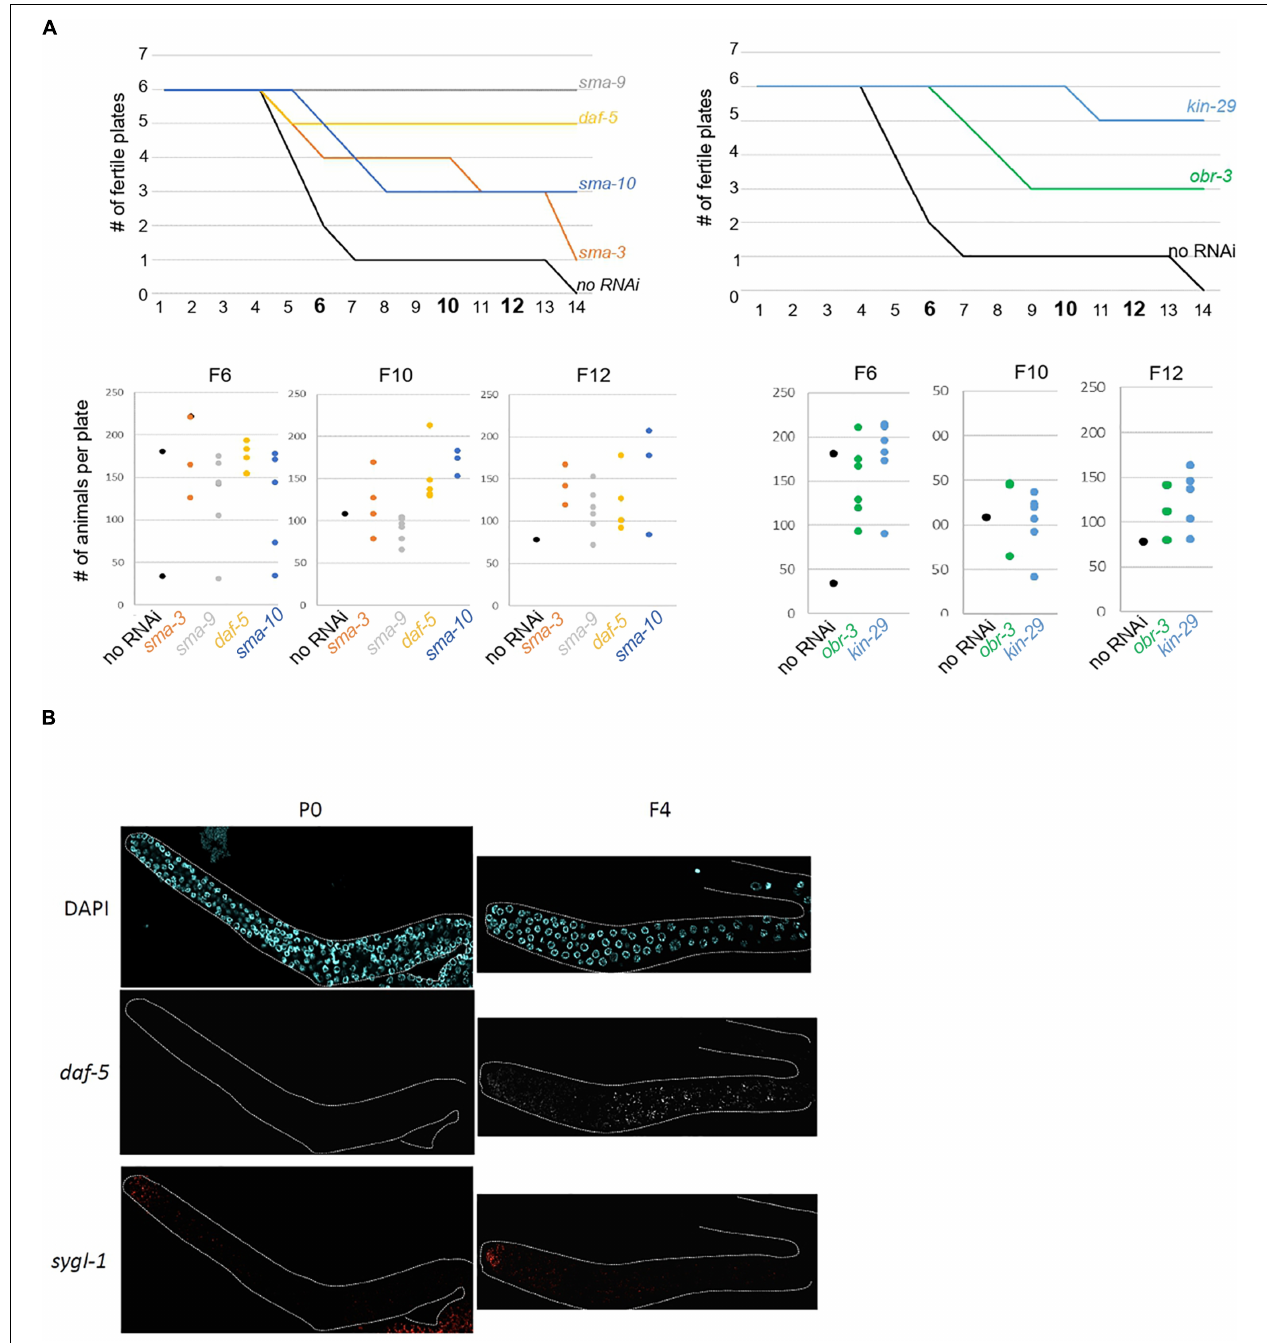
FIGURE 5 | Ectopic TGF-beta signaling contributes to loss of germline identity in set-2 mutant animals. (A) sma-9 , daf-5 , sma-10, and sma-3 RNAi knock-down (left panel) and kin-29 and obr-3 RNAi knock-down (right panel) delay the onset of sterility of set-2 mutant animals compared to animals fed with an empty RNAi vector (no RNAi). Number of fertile plates per generation (upper panel) and number of animals per fertile plate in F6, F10, and F12 (lower panel) are shown. (B) Detection by smFISH of daf-5 (upregulated contributor) and sygl-1 (control gene) transcripts in P0 set-2 /+ and F4 set-2 / set-2 germlines. The distal tip of the gonad is on the